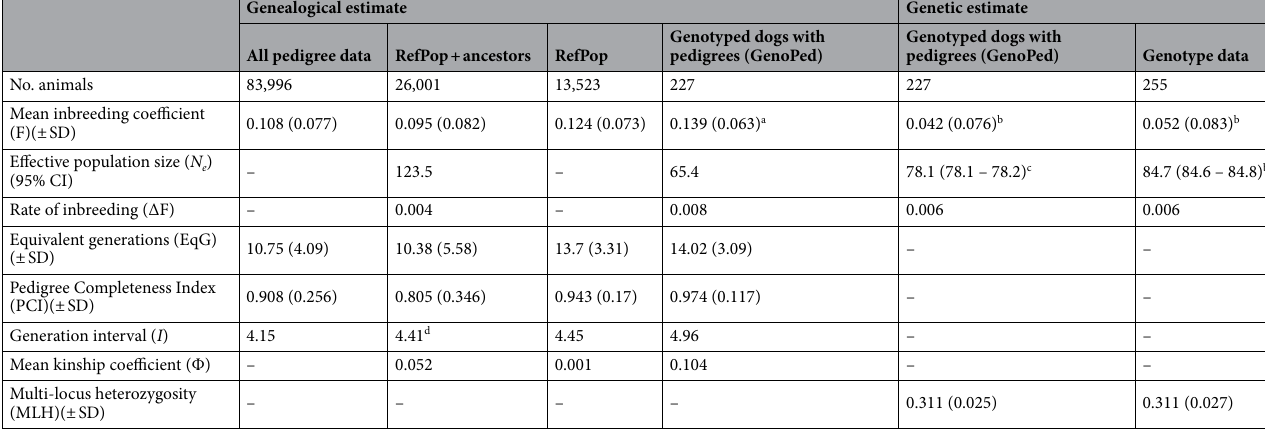
Table 3. Comparison of pedigree and genetic estimates of diversity. a Excludes 11 dogs where inbreeding could not be calculated due to incomplete pedigree information. b F geno value. c Based on lowest allele frequency of 0.05, calculated using the same 10,000 random SNPs. d Calculated from 19,731 dogs with non-missing birth